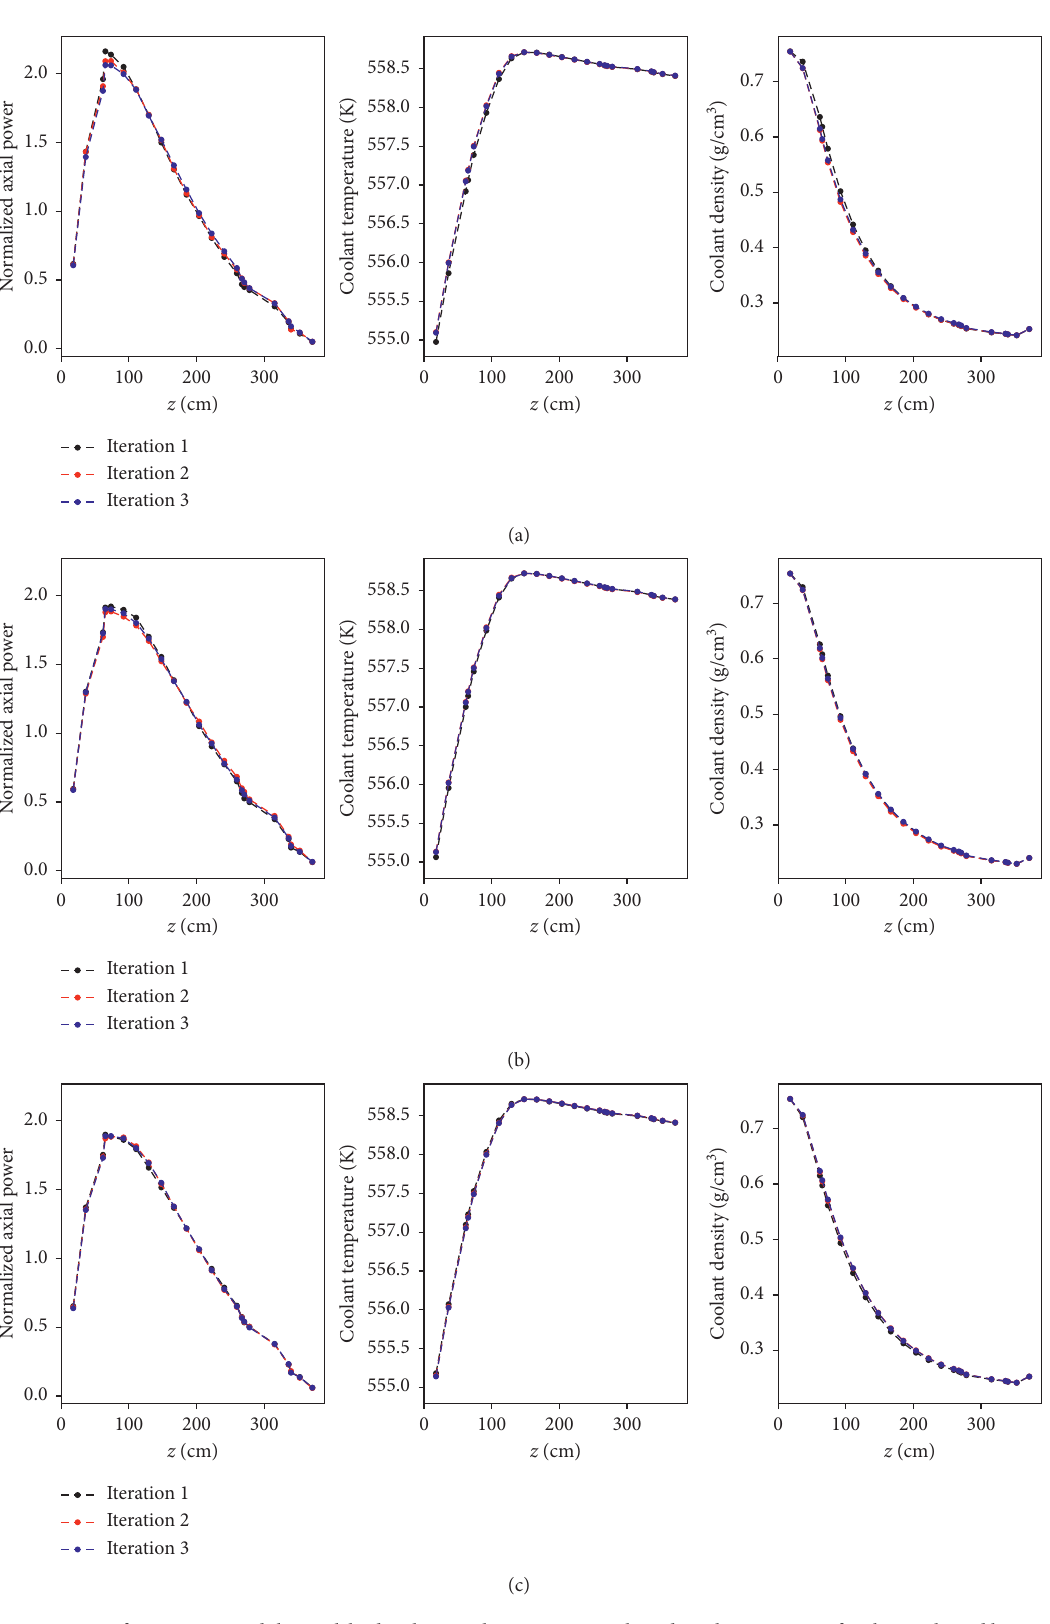
Figure 6: Convergence of neutronics and thermal-hydraulic coupling parameters based on the 2F2D1/F6 for three selected burnup steps. (a) BU step 1. (b) BU step 6. (c) BU step